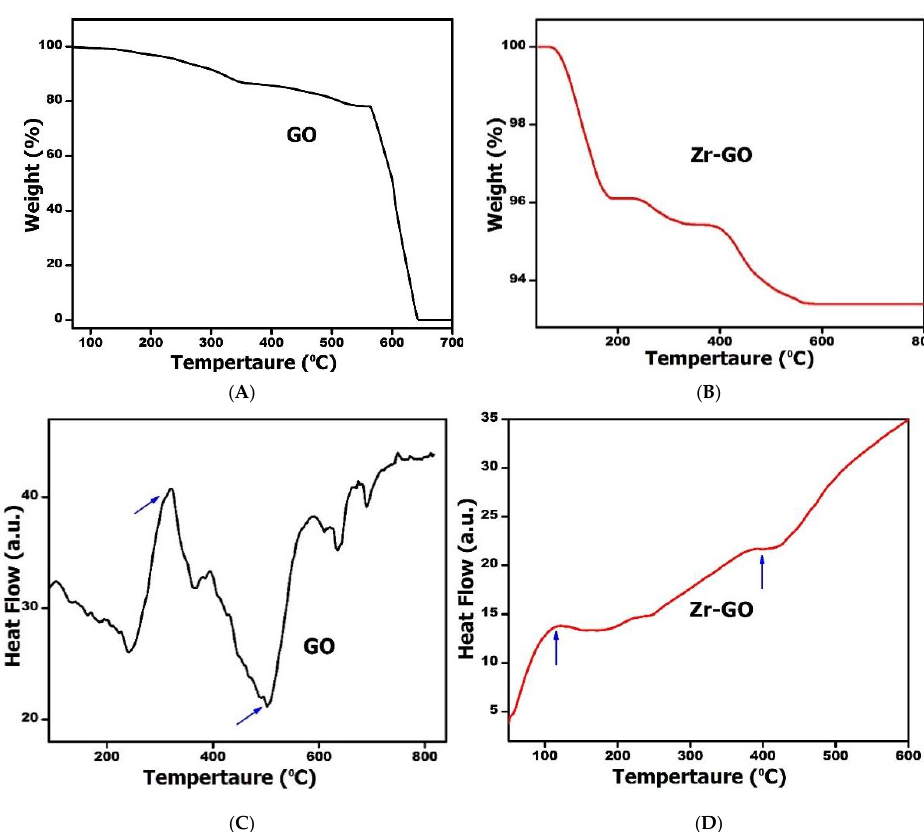
Figure 6. TGA and DSC curves for GO ( A,C ) and Zr-GO ( B,D ) composite.